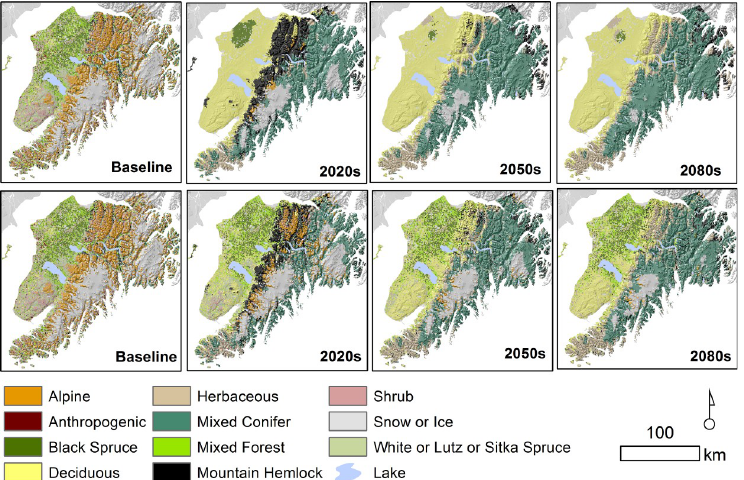
Fig 2. Baseline and forecast vegetation. Comparison of the baseline vegetation on the Kenai Peninsula, Alaska, and the 2020, 2050 and 2080 forecasts. The forecasts represent the vegetation with the highest 6-model average score (top row) and the highest average score moderated by a minimum threshold for change (lower row). The 6-model average represents 2 RCPs and 3